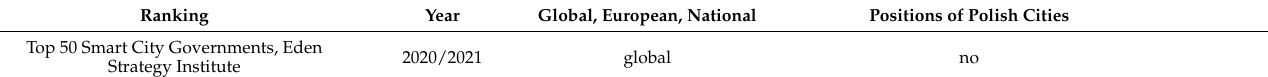
Table 3. Positions of Polish cities in Smart City